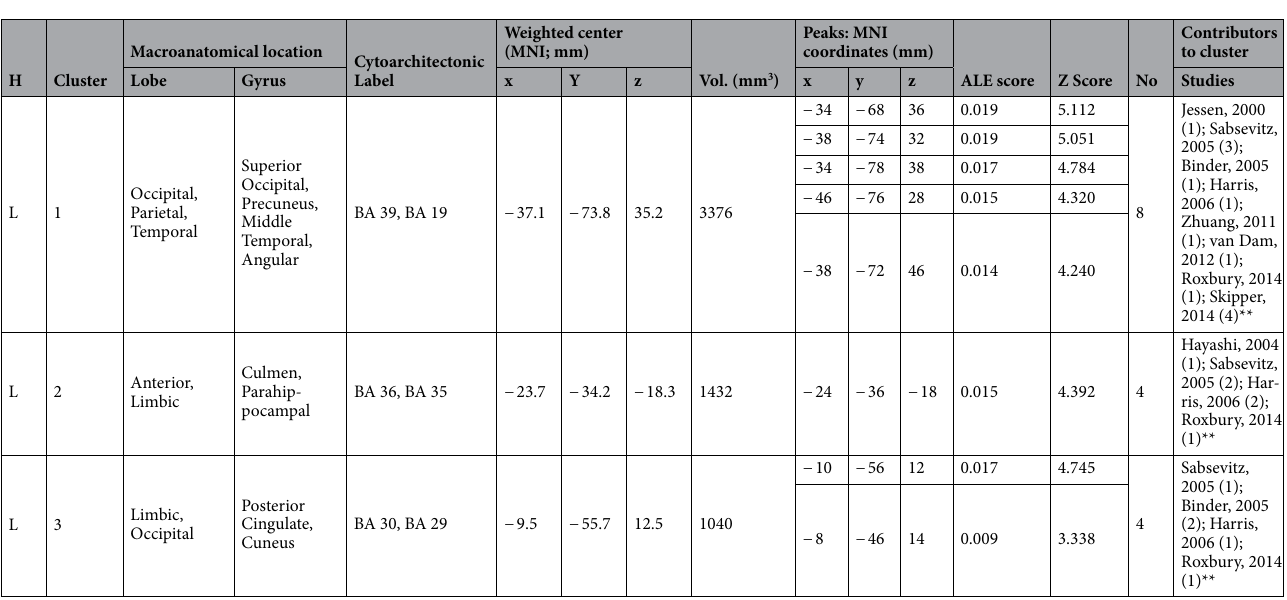
Table 3. Concrete > abstract nouns clusters. Included 107 stereotactic activation loci from 15 studies, 251 participants, Chosen min. cluster size 720 mm 3 . All the values and labels were extracted from the GingerALE output files. Clusters are ordered for decreasing volume size. Coordinates (x, y, z) are in the MNI space. H = Hemisphere; ALE = activation likelihood estimation; Nr. = number of studies that contributed to each cluster; L = left; BA = Brodmann area; ** = between brackets are the number of foci from each study that contributed to that specific